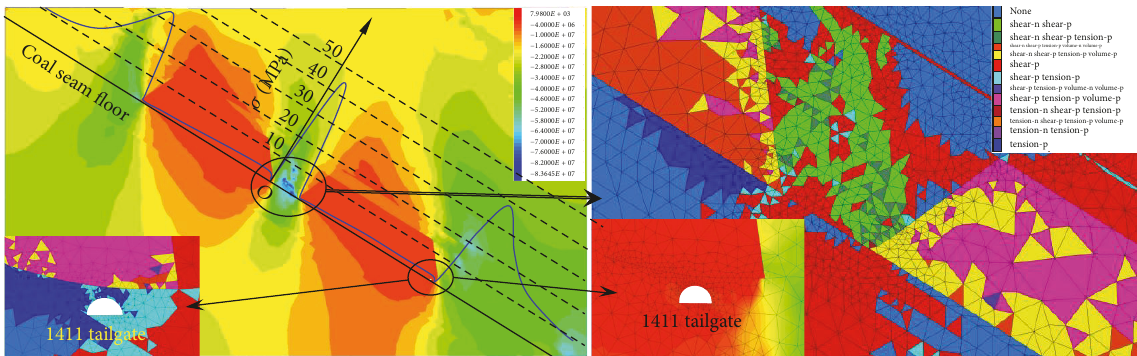
Figure 16: Stress distribution and yield elements after extraction of 1410 panel and development of 1411